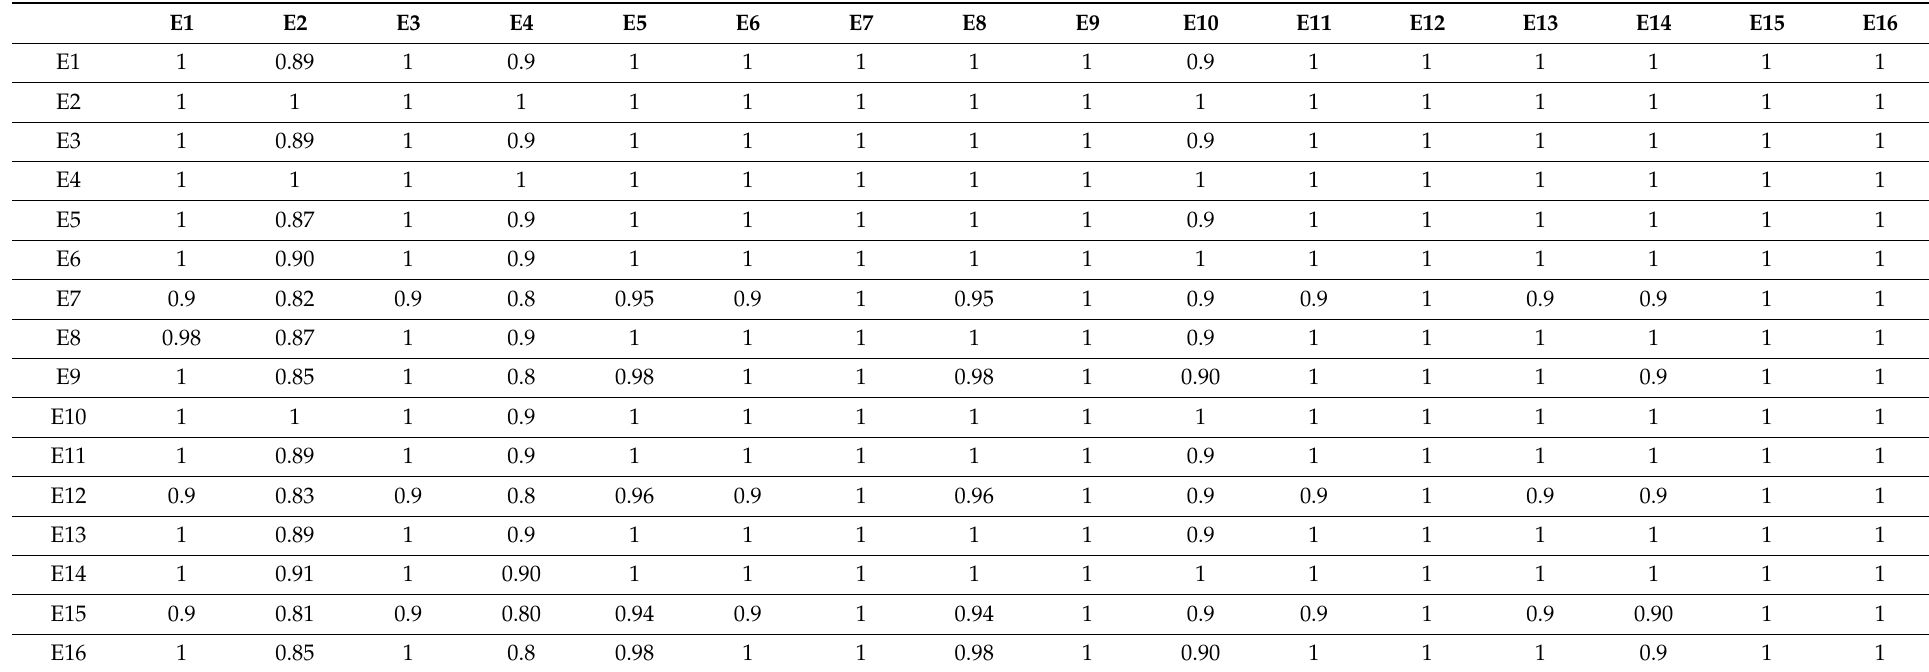
Table A6. Effect–effect matrix to conversion knowledge.